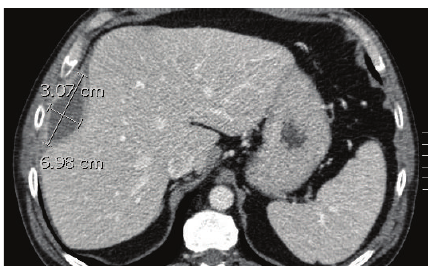
Figure 1: Gallstone-associated perihepatic abscess on preoperative computed tomography measuring 6.98 cm × 3.07 cm.